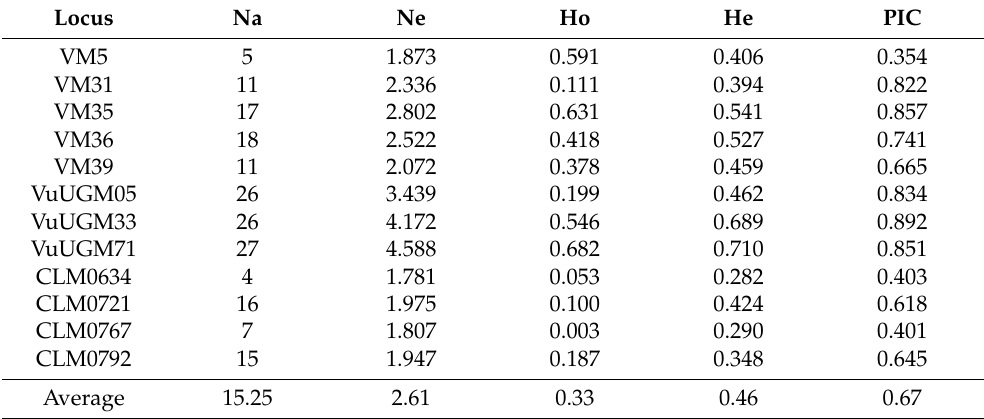
Table 1. Genetic diversity across twelve SSR loci. Na—number of alleles; Ne—effective number of alleles; Ho—observed heterozygosity; He—expected heterozygosity; PIC—Polymorphism Information Content.